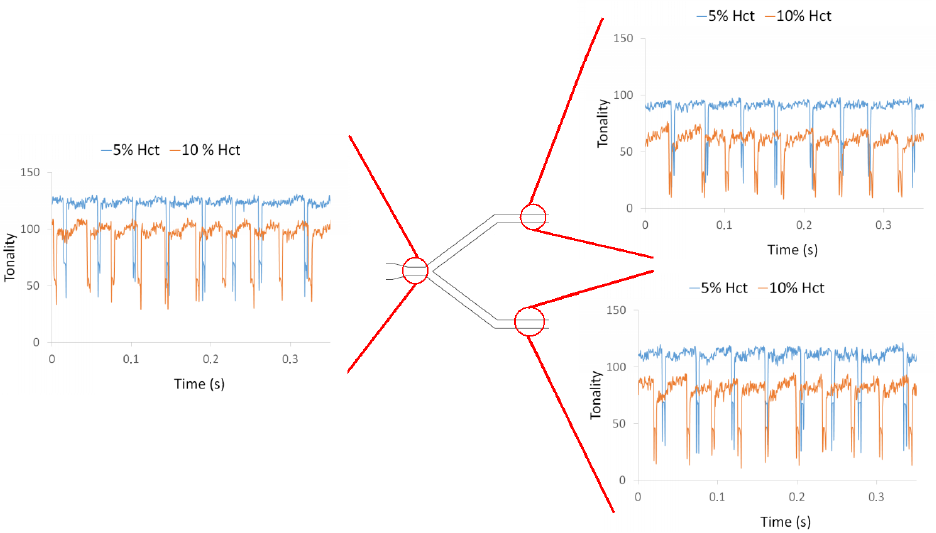
Figure 8. Influence of air bubbles on the local Hct for a flow rate of 10 µL/min for 5% Hct and 10% Hct at the first bifurcation (B1).